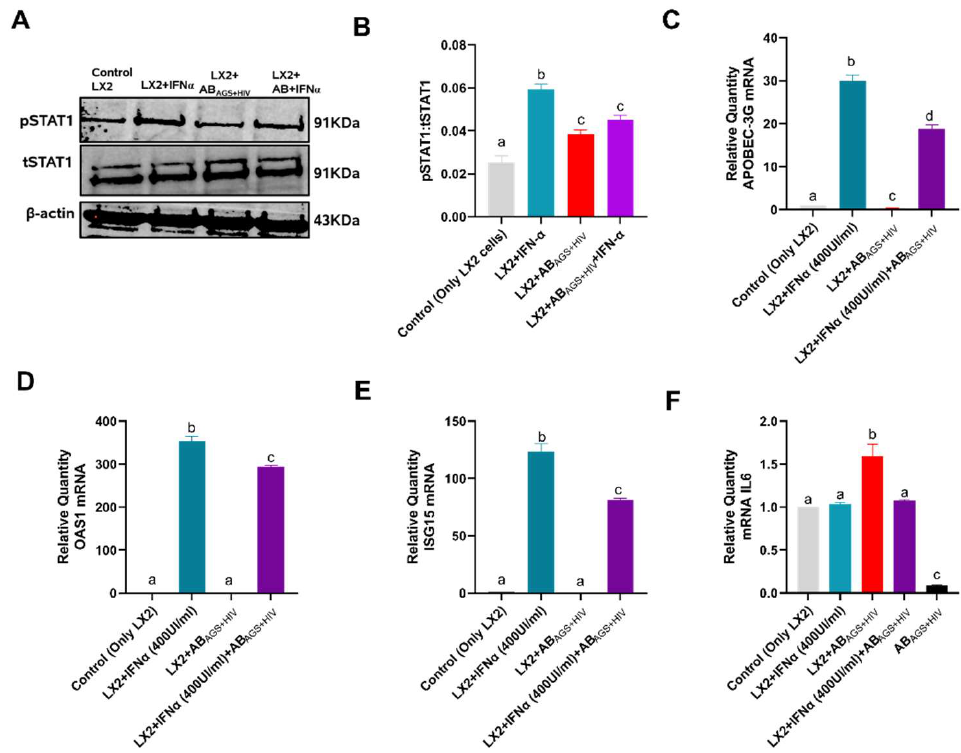
Figure 8. Engulfment of AB AGS+HIV attenuates STAT1 activation and concurrently upregulates IL6 mRNA, leading to profibrotic activation: ( A , B ) STAT1 was measured by immunoblot analysis and the quantification of immunoreactive protein bands. Equal amounts of protein (20 µ g) were loaded in each lane. β -actin was used as an internal control. RT-PCR analysis of ( C ) APOBEC-3G mRNA, ( D ) OAS1 mRNA, ( E ) ISG15 mRNA, and ( F ) IL6 mRNA. Data are from 3 independent experiments presented as mean ± SEM. Bars marked with the same letter are not significantly different. Bars with different letters are significantly different from each other ( p ≤